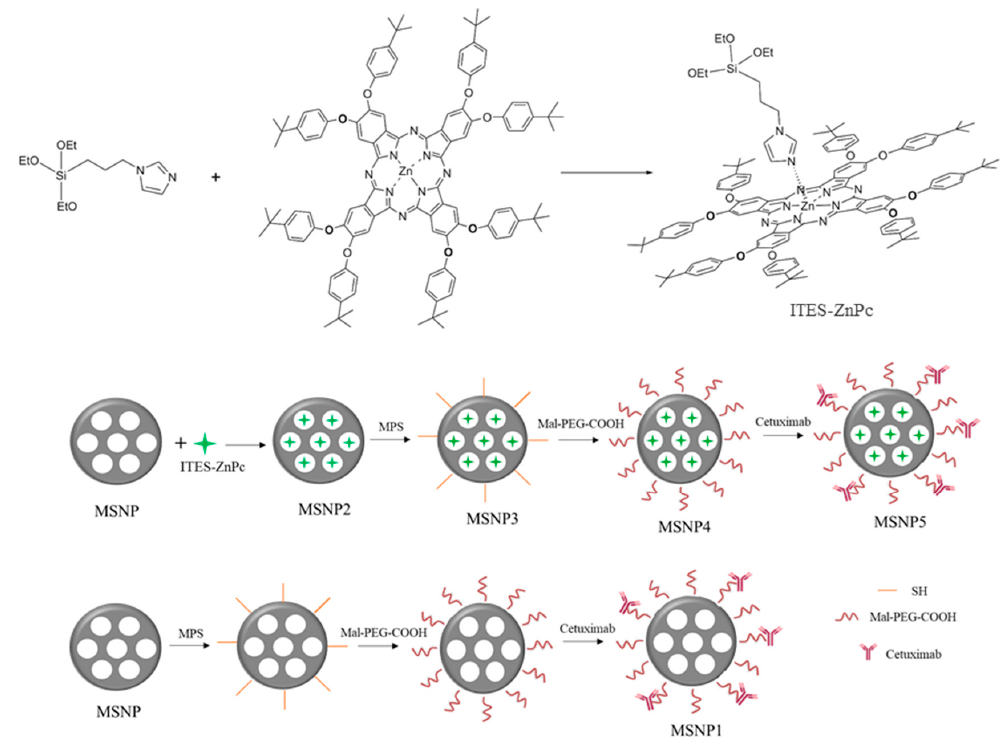
Scheme 2. Preparation of the nanoparticles.